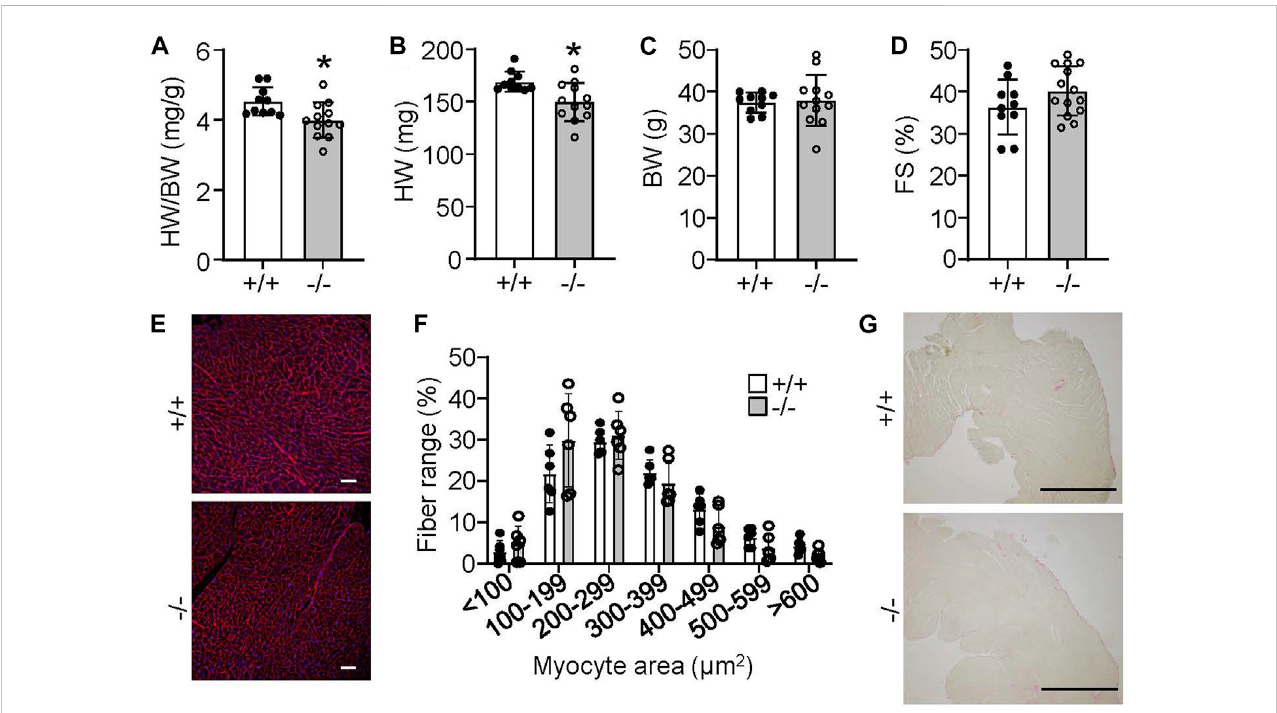
FIGURE 5 Rpl3l − / − micehavereducedheartsizeat18 monthsofage. (A – C) HW/BWratio,absoluteHWandabsoluteBWin Rpl3l − / − ( − / − )andwildtype(+/+)miceat 18 months of age ( n = 10 – 12, * = p < 0.01. (D) Fractional shortening (FS) measured by echocardiography at 18 months of age in the two indicated groups of mice( n =10 – 14). (E,F) Microscopicimagesofcardiachistologicalsectionsstainedwithwheatgermagglutinin(WGA)-Alexa fl uor594conjugateinred (E) and quanti fi cation (F) of cardiomyocyte cross-sectional area between wild type and Rpl3l − / − mice at 18 months of age from the histological images (scale bars = 100 µm). (G) Microscopic images of cardiac histological sections stained with picrosirius red to show collagen deposition between the two groups of mice at 18 months of age (scale bars = 1 mm). Data are mean ±